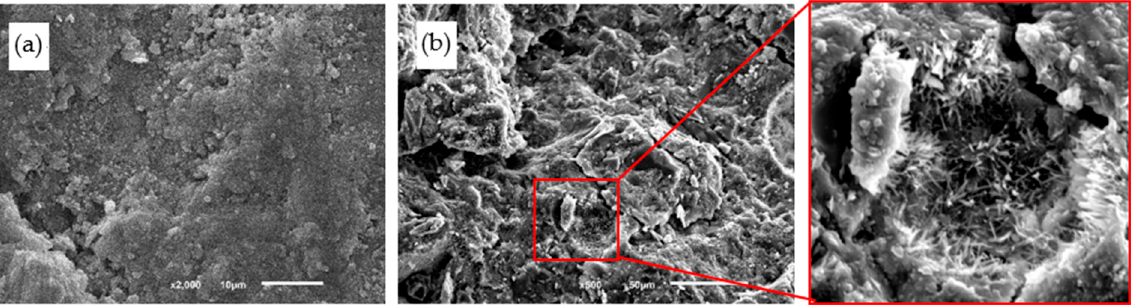
Figure 11. Microstructures of control PCPC. ( a ) Without wet-dry cycle and ( b ) with 12 wet-dry cycles in acid rain solution.